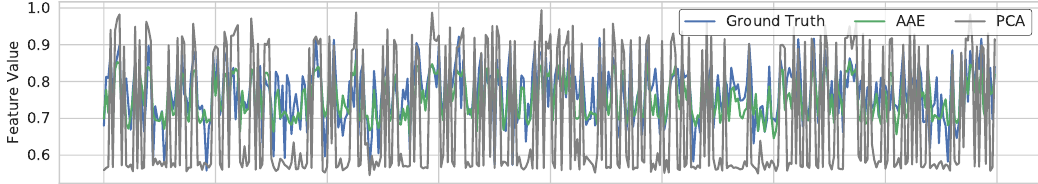
Figure 7. Restoration of an audio (MFCC) feature values with AAE and PCA. An entire modality is dropped and reconstructed using features from the remaining